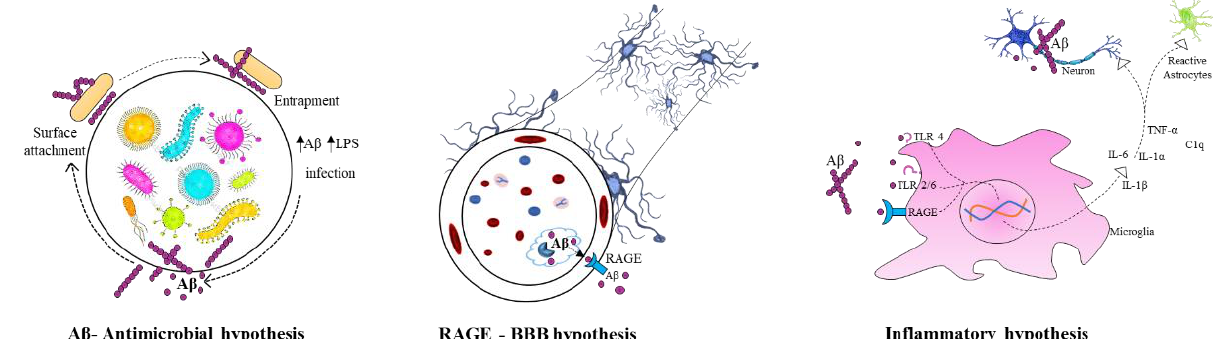
Figure 2. Infectious hypothesis in Alzheimer’s disease.